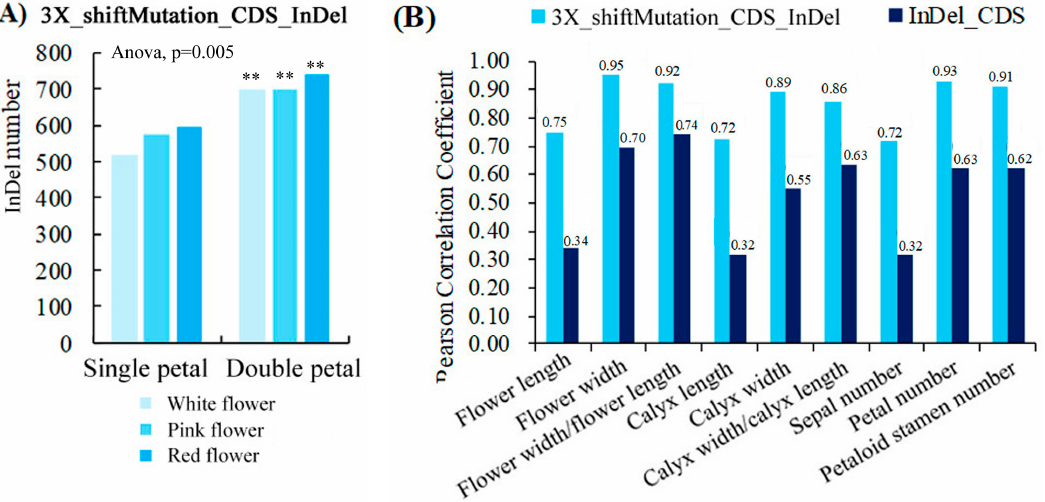
Figure 5. Quantitative statistics of 3X_shiftMutation_CDS_InDels and its correlation with phenotypic parameters. ( A ) Quantitative statistics of 3X_shiftMutation_CDS_InDels; ( B ) Correlation analysis between two types of InDels and morphological parameters. Two asterisks indicated significant differences at p < 0.01, between the two types of flowers (single- and double-petals) according to the Duncan test.